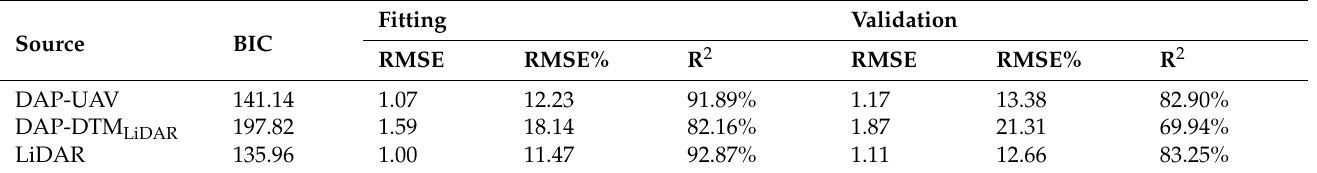
Table 11. Fitting and validation statistics of the best models for estimating mean dbh from DAP-UAV, DAP-DTM LiDAR , and